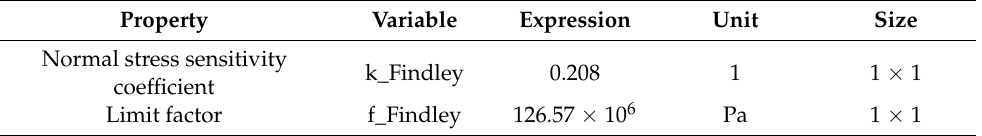
Table 6. Definition of material properties for the Findley fatigue simulation.